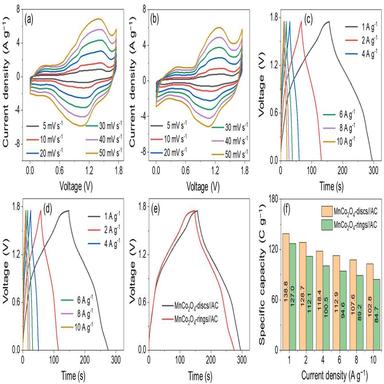
CV curves of (a) MnCo2O4-discs//AC ASC and (b) MnCo2O4-rings//AC ASC at a scan rate of 5 − 50 mV s − 1 ; the GCD curves of (c) MnCo2O4-discs//AC ASC and (d) MnCo2O4-rings//AC ASC under a current density of 1 − 10 A/g; (e) the GCD curves of MnCo2O4-discs//AC ASC and MnCo2O4-rings//AC ASC at 1 A/g and (f) the rate performance of the MnCo2O4-discs//AC and MnCo2O4-rings//AC ASCs.